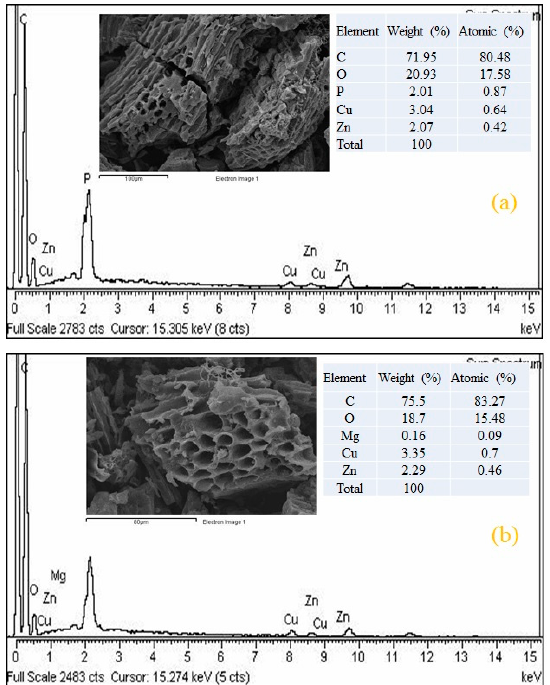
Figure 2. ( a ) Energy dispersive spectrum (EDS) of MA-AC400 before RO16 adsorption; ( b ) EDS of MA-AC400 after adsorption of RO16 dye.